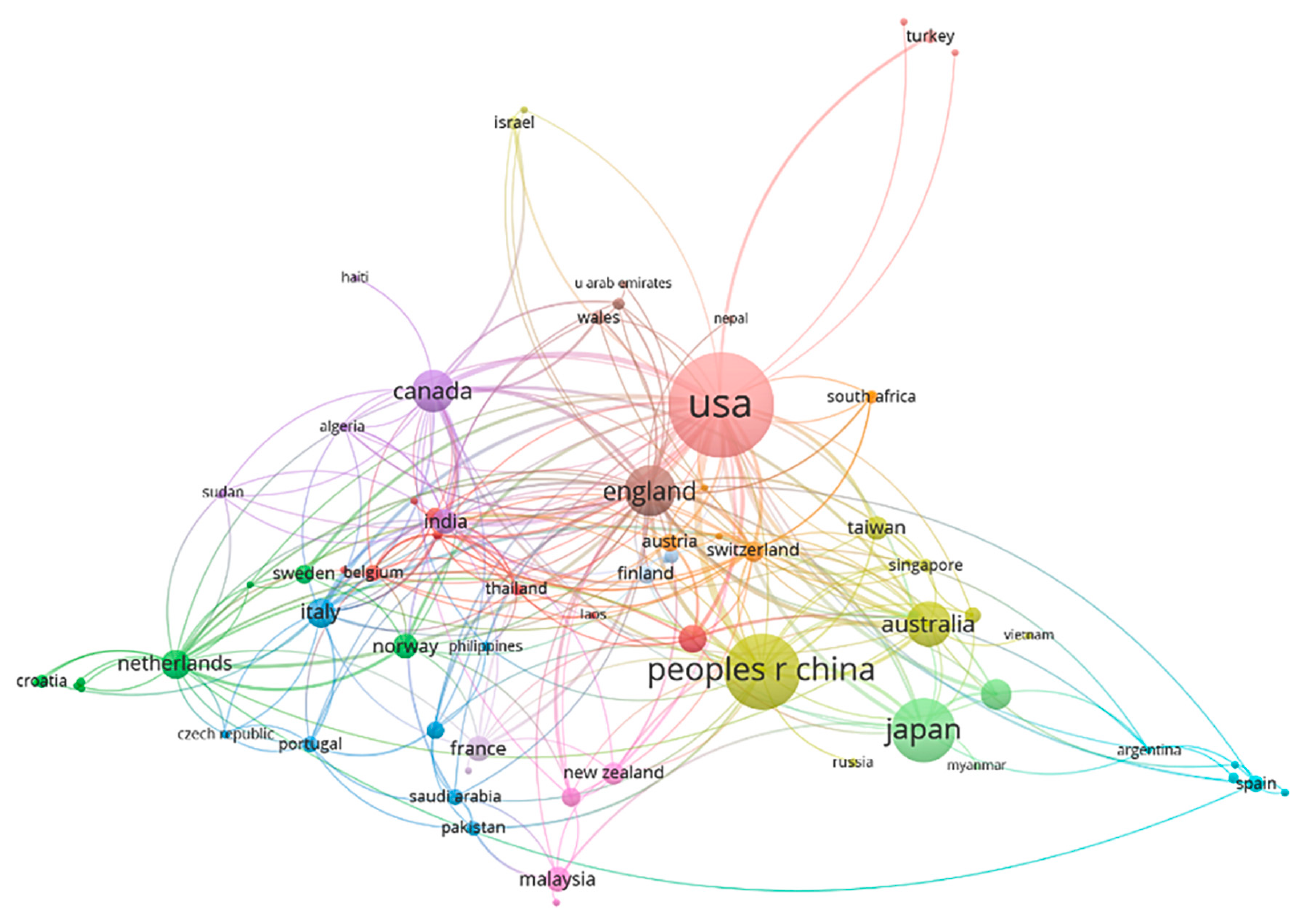
Figure A1. Collaboration network map of main countries.